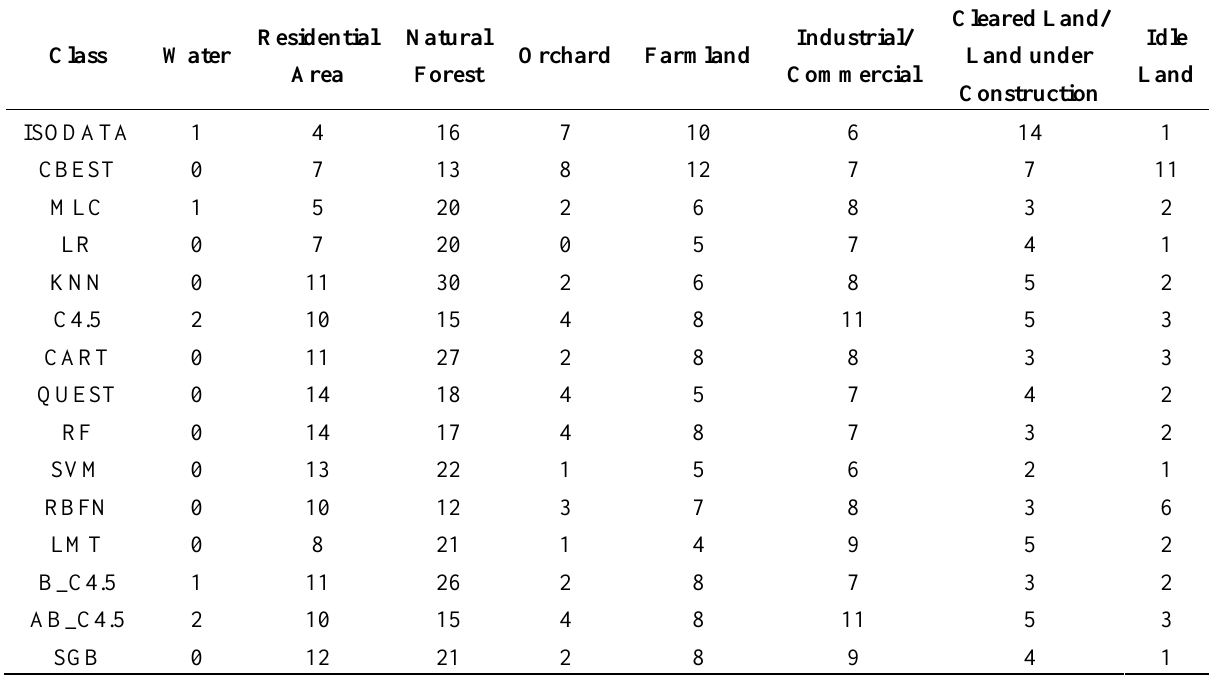
Table 6. The number of misclassified pixels by different algorithms.